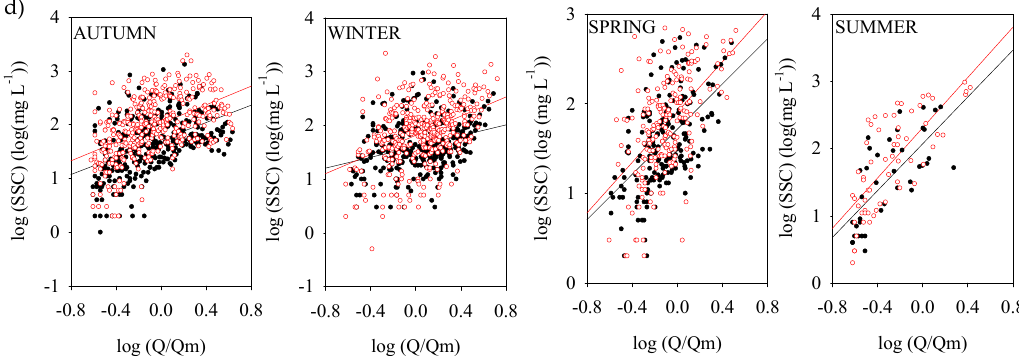
Figure 6. Relationship (double-logarithmic scale) between stream discharge (Q) and suspended sediment concentration (SSC) at different temporal scales and limbs of the hydrograph. ( a ) all data; ( b ) data split by season; ( c ) data split based on rising and falling limb; and ( d ) seasonal data split based on rising and falling limb.